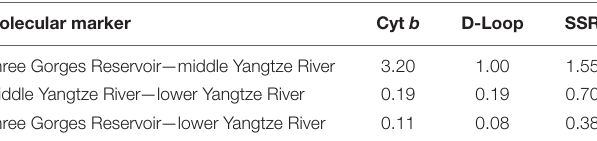
TABLE 4 | Gene flow between different groups based on mtDNA and SSR